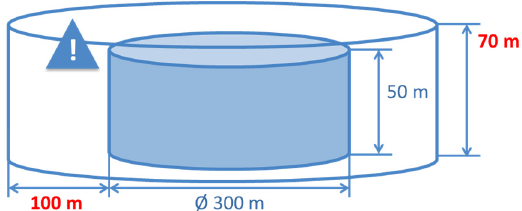
Figure 9. Minimum dimensions for NFZ alert distances found in our tests.